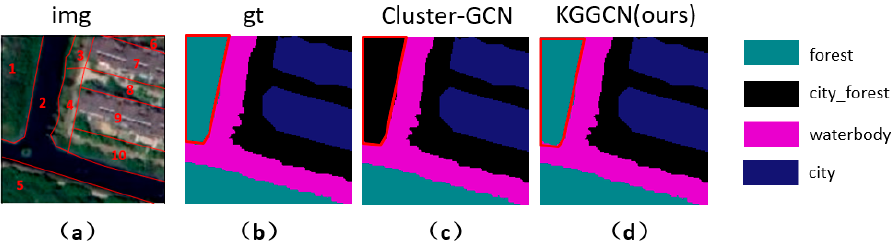
Figure 25. Demonstration of one sample. ( a ) is the raw remote sensing image and superpixel blocks are marked in the image; ( b ) is the ground truth of this image; ( c ) is the prediction of Cluster-GCN; ( d ) is the prediction of KGGCN.